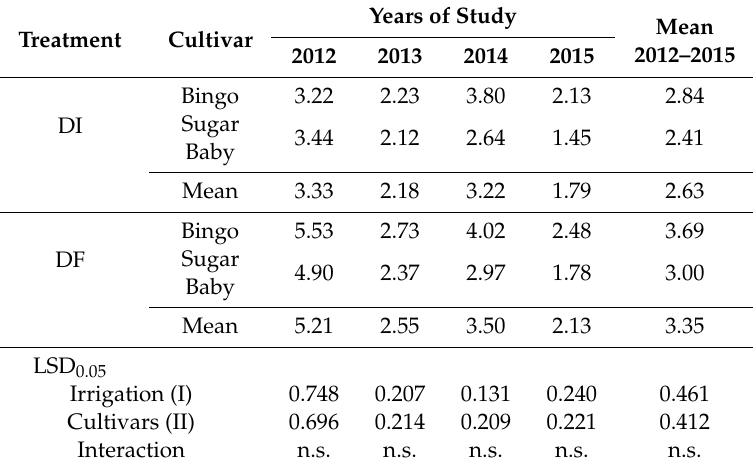
Table 5. Influence of nitrogen fertigation on the single fruit weight (kg) of two watermelon cultivars: Bingo and Sugar Baby (2012–2015).